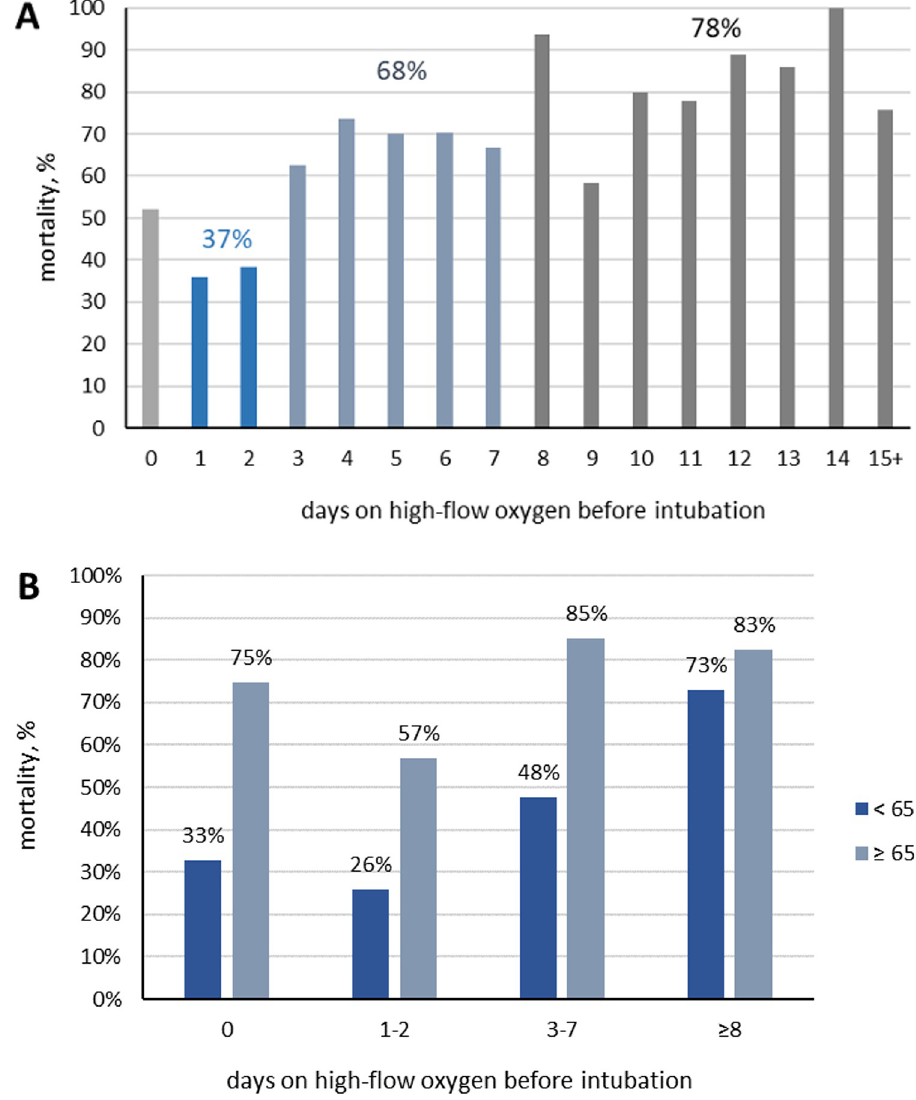
Fig 2. Inpatient mortality was higher with longer use of high flow oxygenation before intubation. (A) Inpatient mortality vs days on noninvasive oxygenation support differed across time intervals: Lowest for 1–2 days, higher for 3–7 days, and highest for 8+ days. (B) Inpatient mortality vs days on noninvasive oxygenation support stratified into 2 age groups: Age < 65 years and age � 65 years. For younger group, differences in mortality for 1–2 days, 3–7 days, and 8+ days. For older group, differences in mortality in 1–2 days and 3+ days